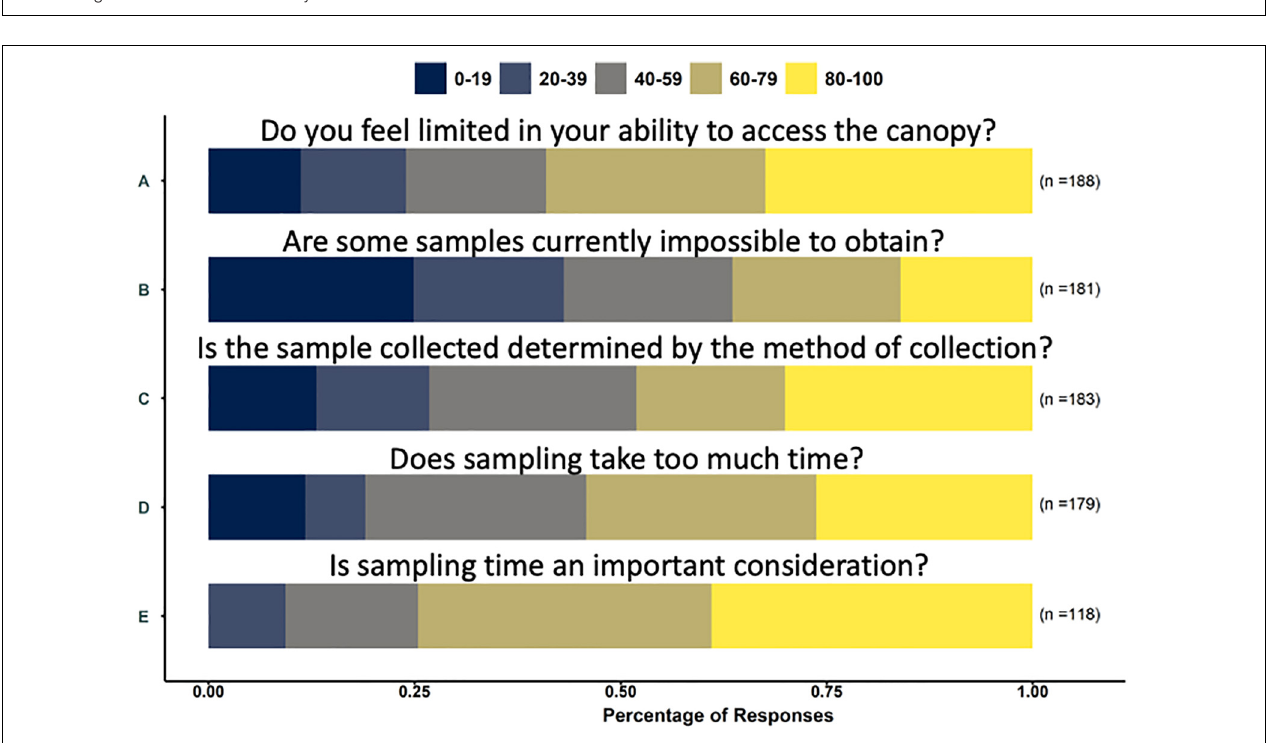
FIGURE 4 | Climate and type of forest where respondents work. Each respondent could choose all applicable options in an online survey about conducting research and management in the arboreal ecosystem.